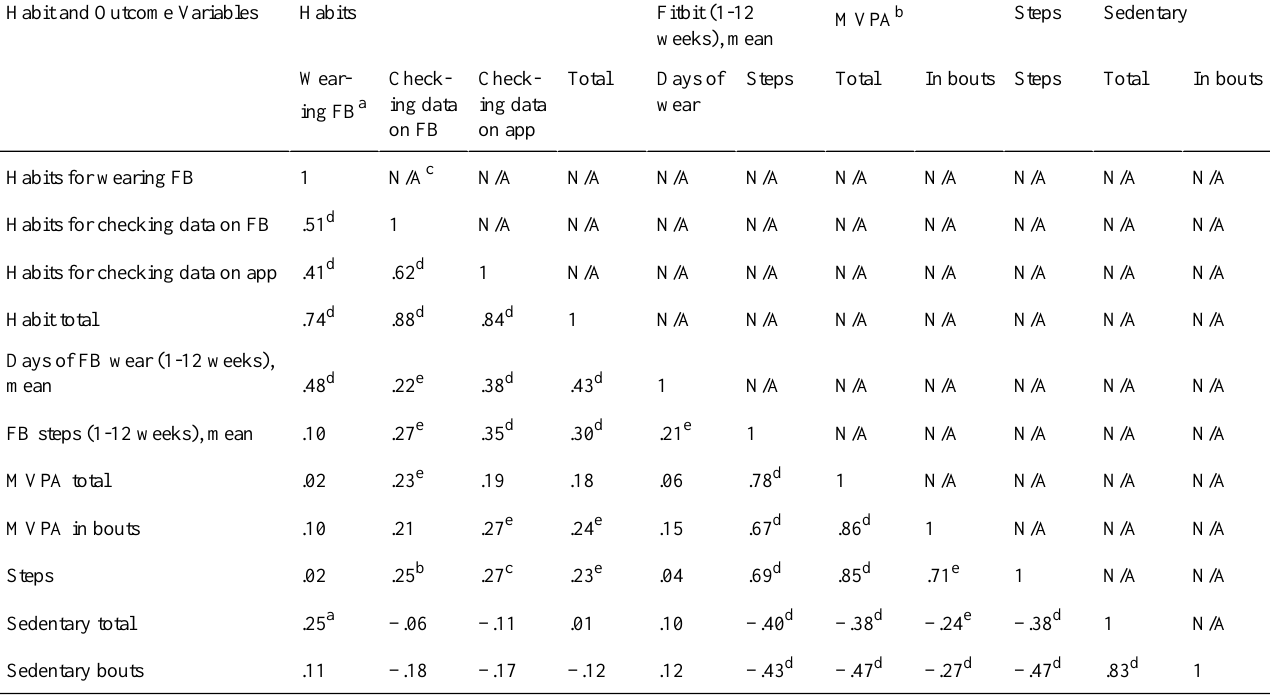
Table 5. The correlation matrix showing relationships among habits associated with wear and use of Fitbits, objectively measured Fitbit wear and steps during the intervention (data collected from Fitbits via Fitabase), and primary outcomes for active and sedentary behaviors (data collected via ActiGraph and activPAL